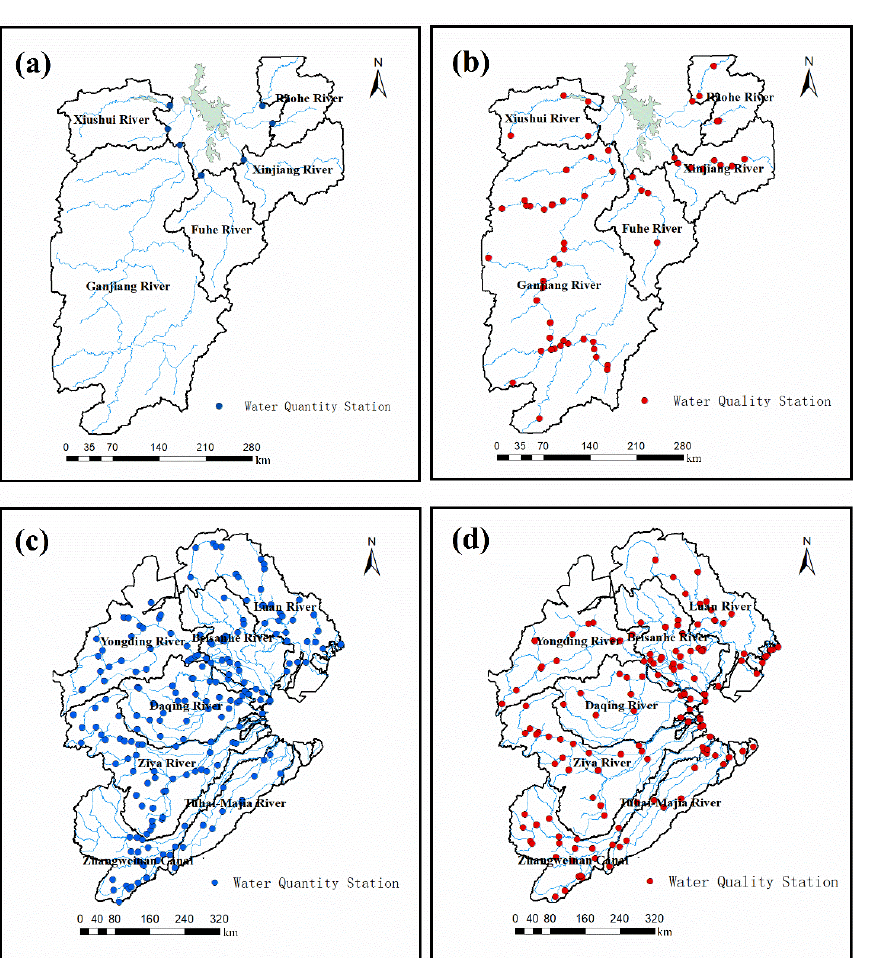
Figure 3. Water quantity station distribution ( a ) and Water quality station distribution ( b ) in PLB, Water quantity station distribution ( c ) and Water quality station distribution ( d ) in HRB.